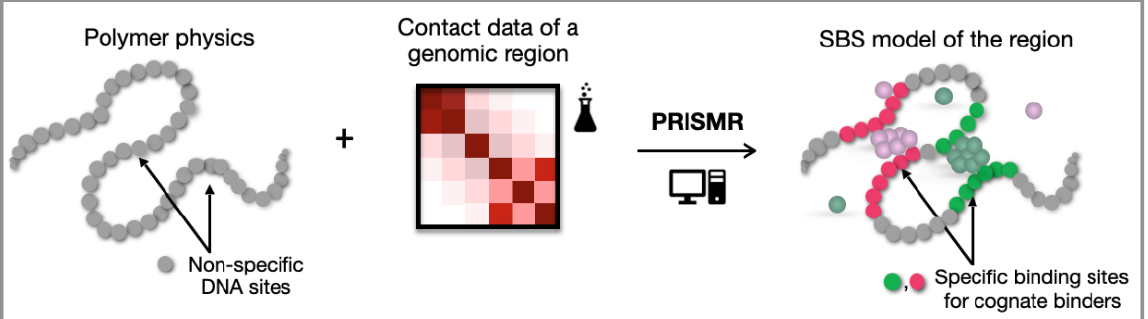
Figure 3. PRISMR and machine learning of 3D genome conformations. PRISMR is a machine learning-based procedure which, informed by a polymer physics model of chromatin and experimental pairwise contact data of a given genomic region of interest, infers the optimal polymer model of the region (adapted from [75]).